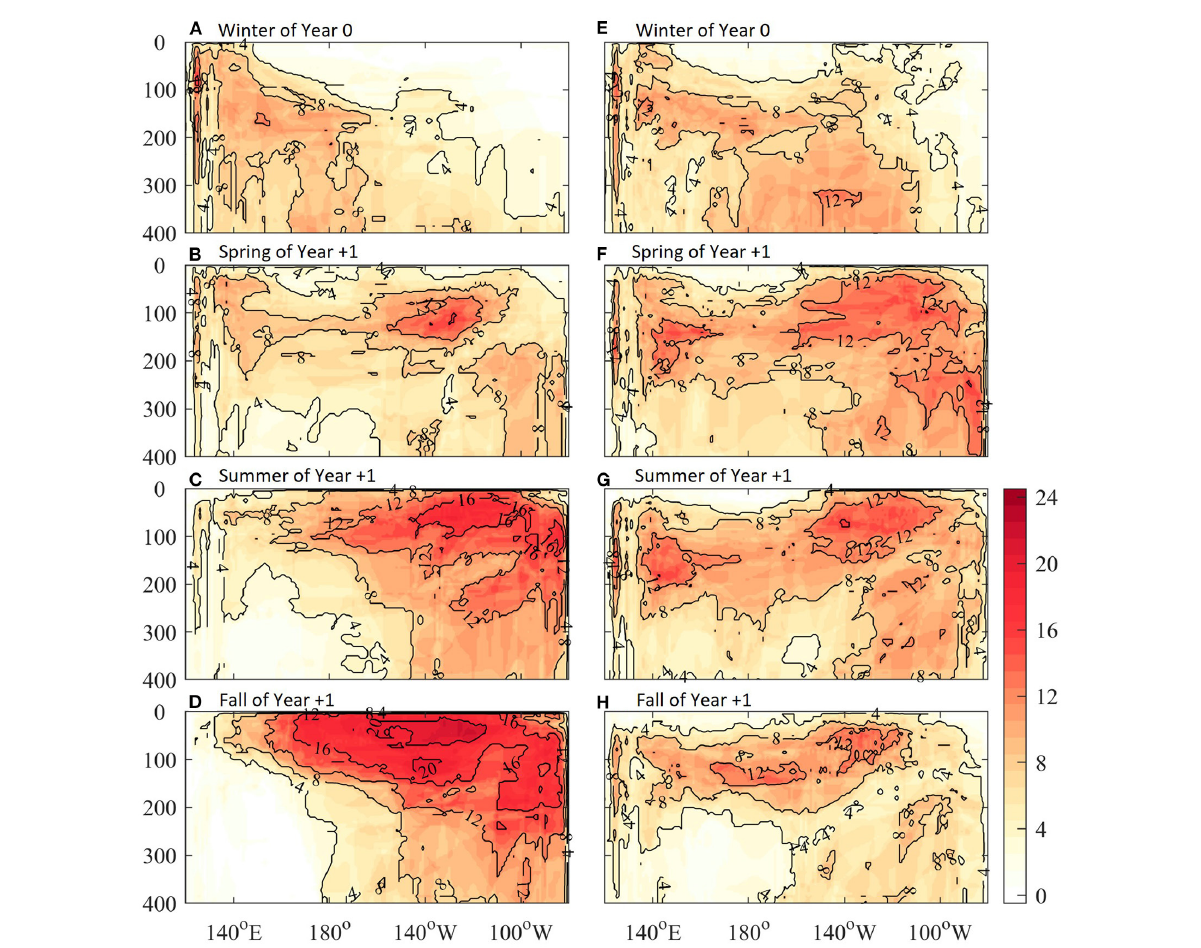
FIGURE8 Numbers of CMIP5 models with significant positive correlations between the STIO SSTA in fall and the subsurface temperature anomalies in the vertical section along the equatorial Pacific in (A) winter of Year + 0, (B) spring of Year + 1, (C) summer of Year + 1, and (D) fall of Year + 1. (E–H) are same as (A–D) , but with the ENSO signal